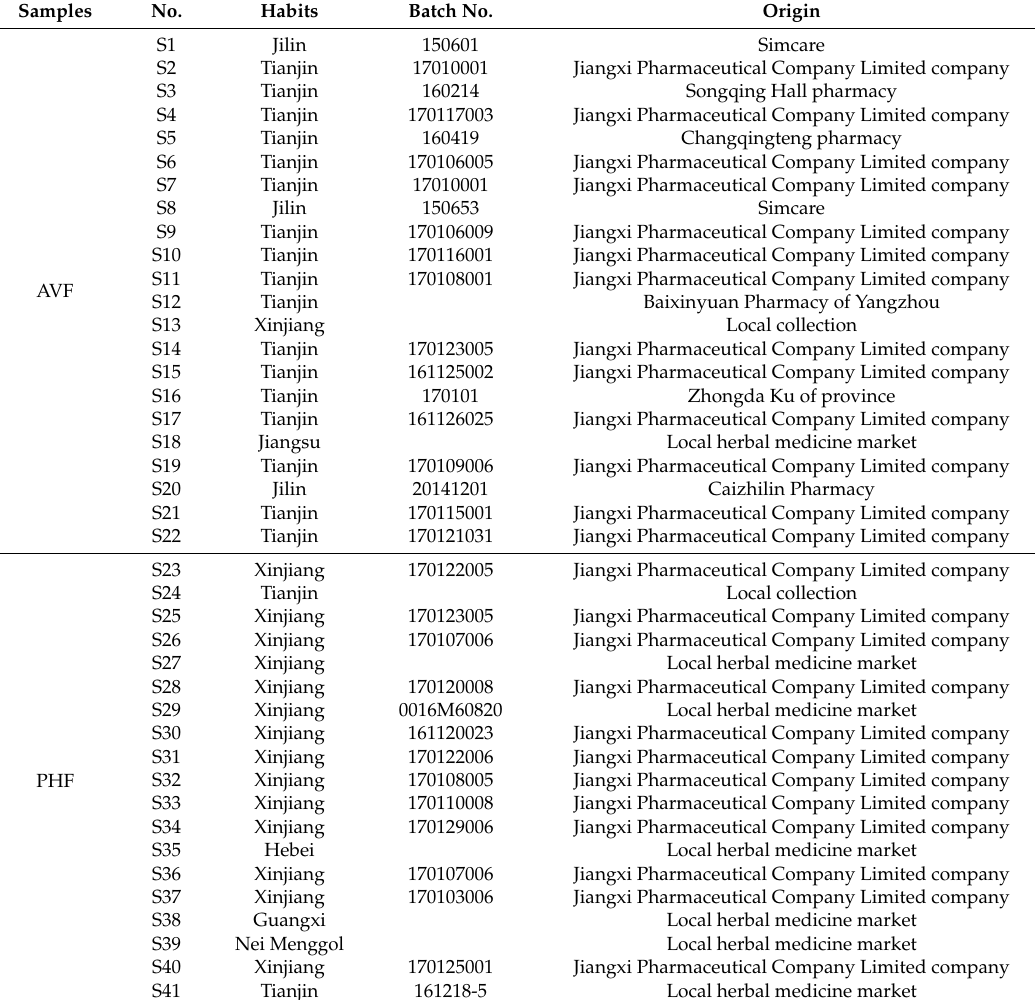
Table 3. Information of tested samples of AVF and